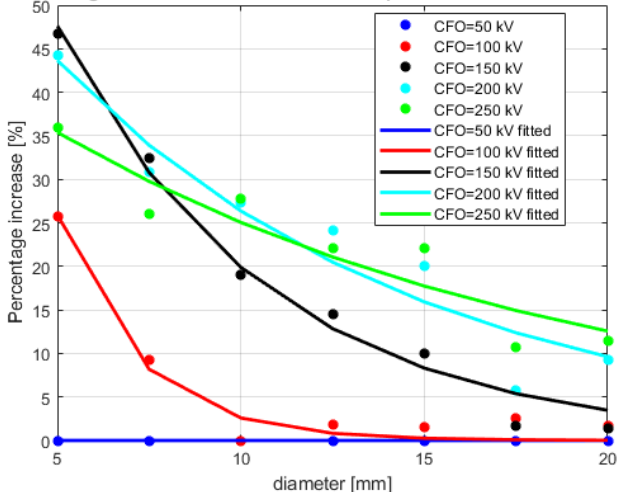
Figure 6. Percentage variation of the number of flashovers as a function of the conductor diameter.